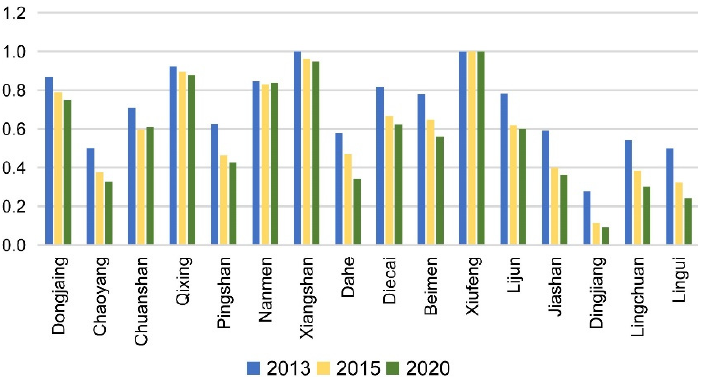
Figure 10. Proportion of population with access to open public space from 2013 to 2020 in townships of Guilin.